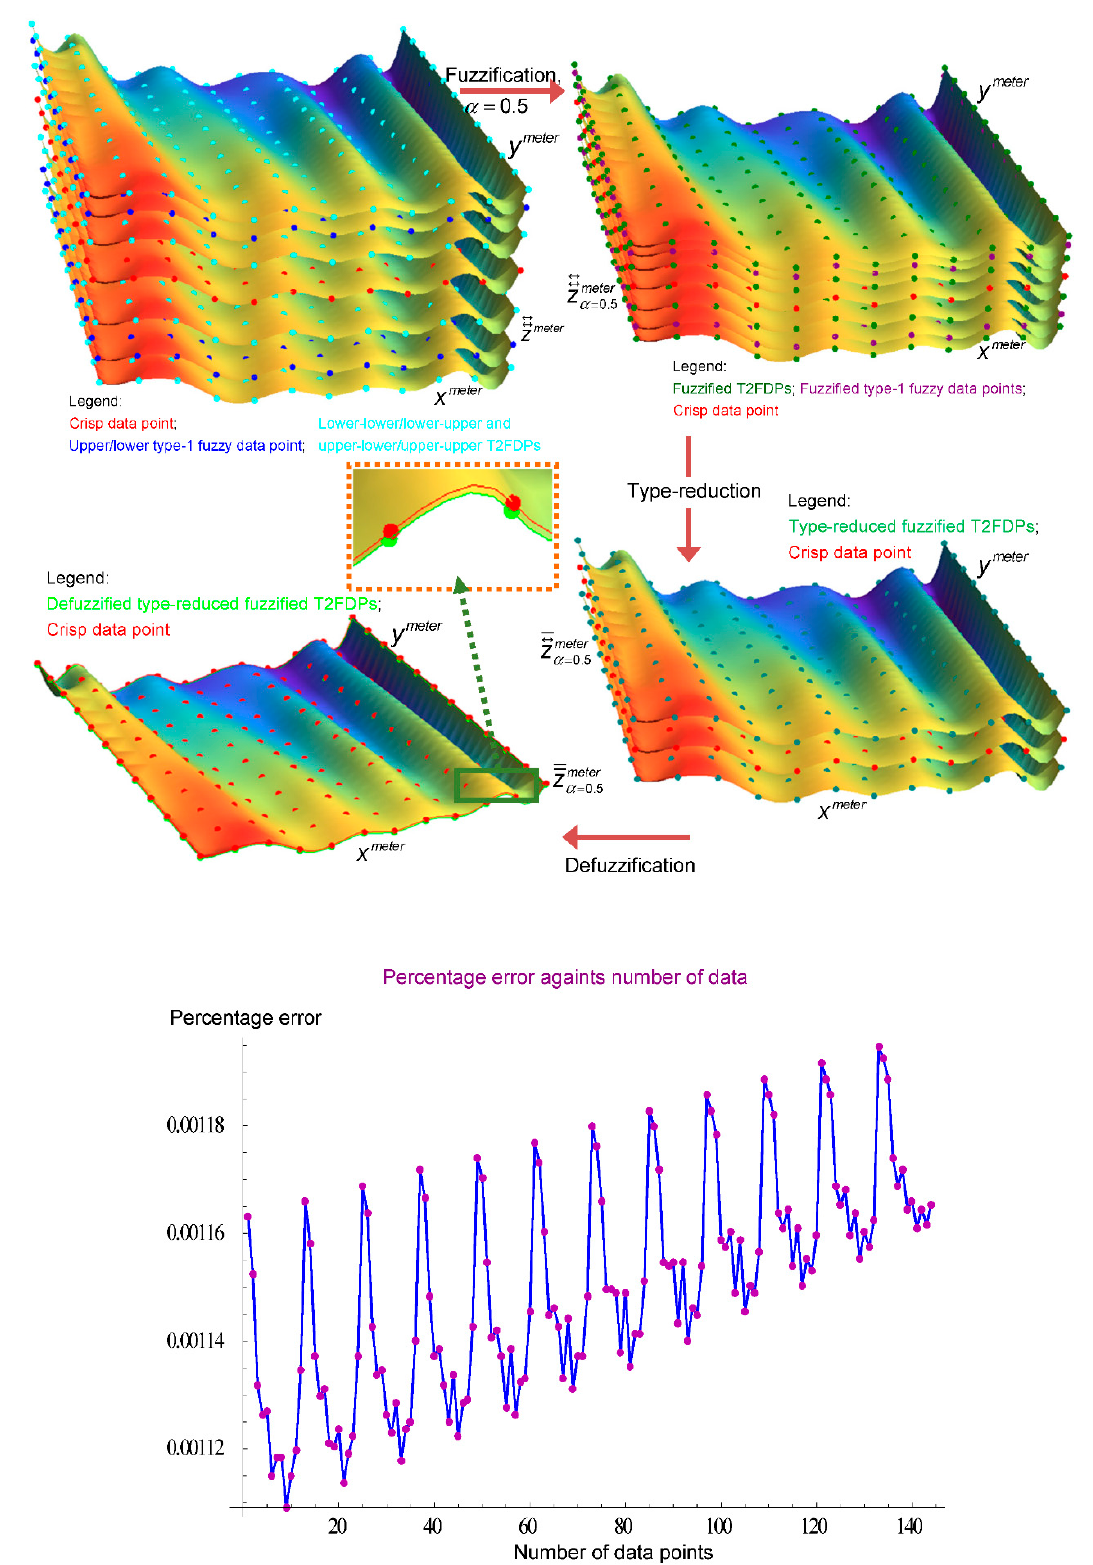
Figure 13. The T2FIBsS modeling through fuzzification until defuzzification processes with α = 0.5 along the error plot.